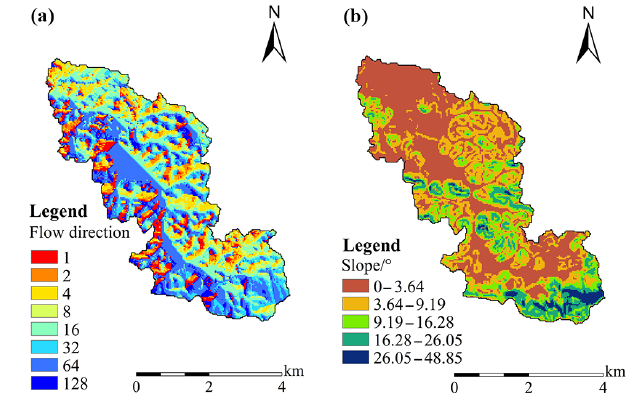
Table 2. Peak Flows of the 3 storms (m 3 s − 1